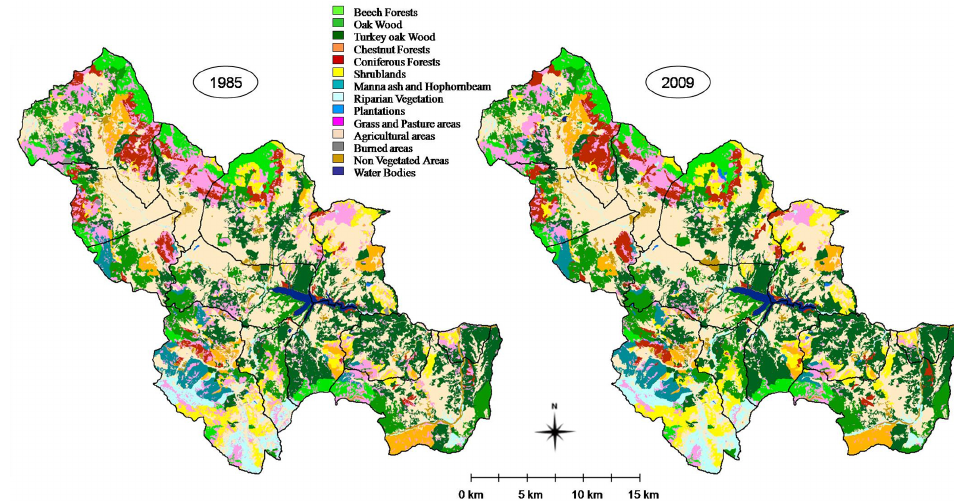
Figure 2. Land cover maps for the years 1985 and 2009 derived from Landsat TM data. Table 2. Land cover classes and corresponding acronyms. Land cover